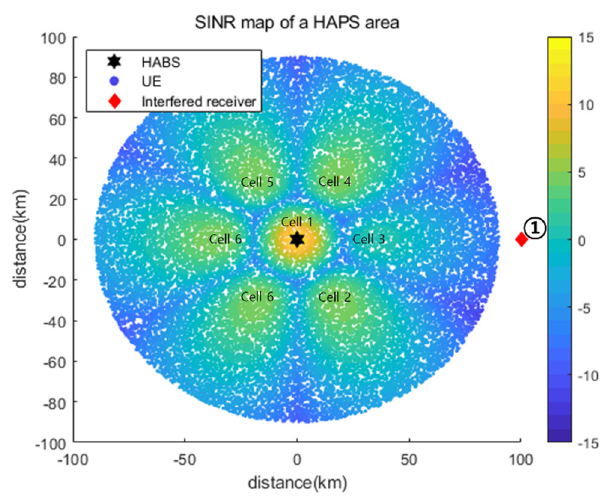
Figure 9. SINR map based on the P c obtained using the proposed DQL-based power control algorithm for interfered receiver ① .